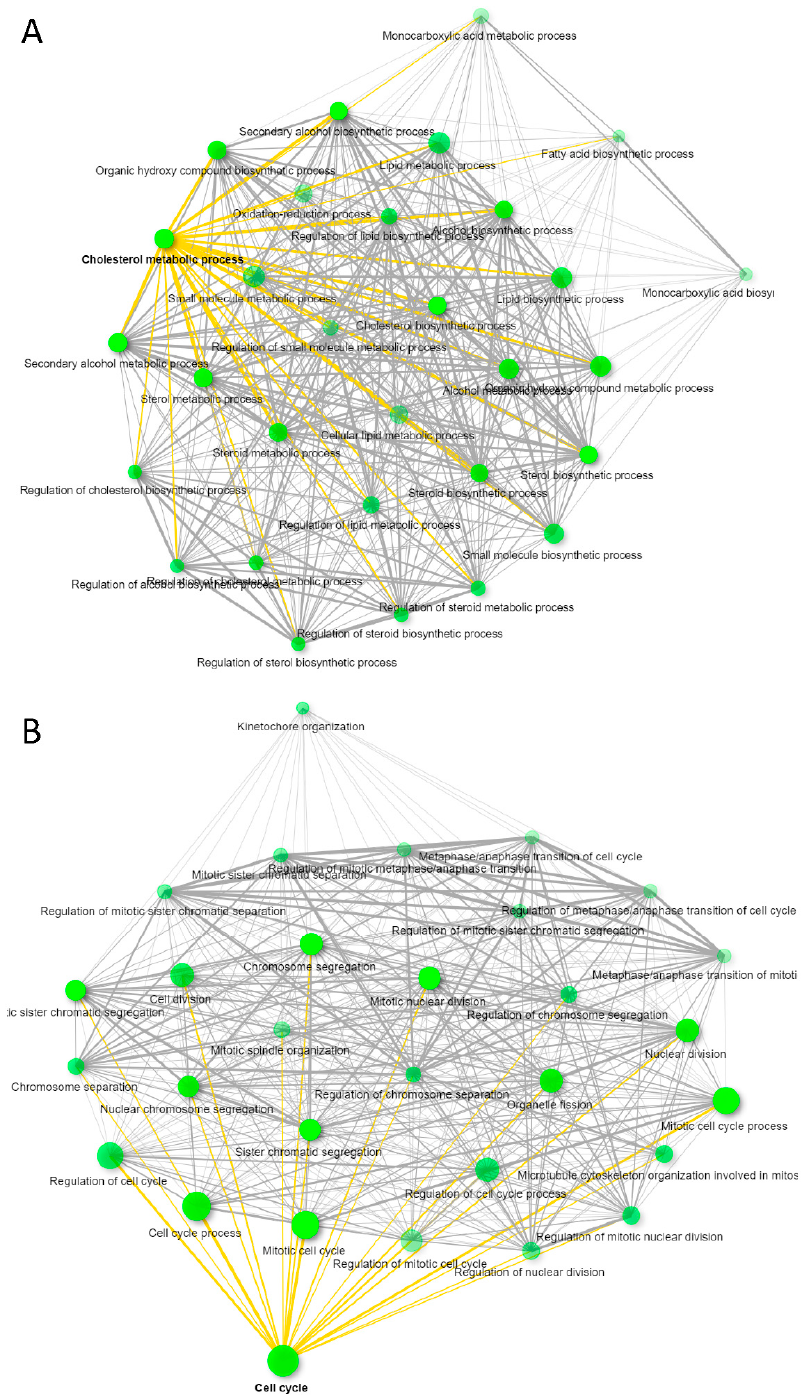
Figure 4. Immunocaptured CD63 + and MHC-I + EVs released from WT Jurkat T cells were co-cultured with HUVEC for 3 days. Differential gene expression of HUVEC untreated vs. CD63 + EV or MHC-I + EV treated HUVEC was determined using microarray analysis. ( A ) GO enrichment pathway network of untreated HUVEC vs. cells treated with WT Jurkat CD63 + EVs (>1.5 ± fold change, p ≤ 0.05). ( B ) GO enrichment pathway network of untreated HUVEC vs. cells treated with WT Jurkat MHC-I + EVs (>1.5 ± fold change, p ≤ 0.05). Supplemental Materials Data files related with ( A , B ); Data/s2A, /Data/s2B,